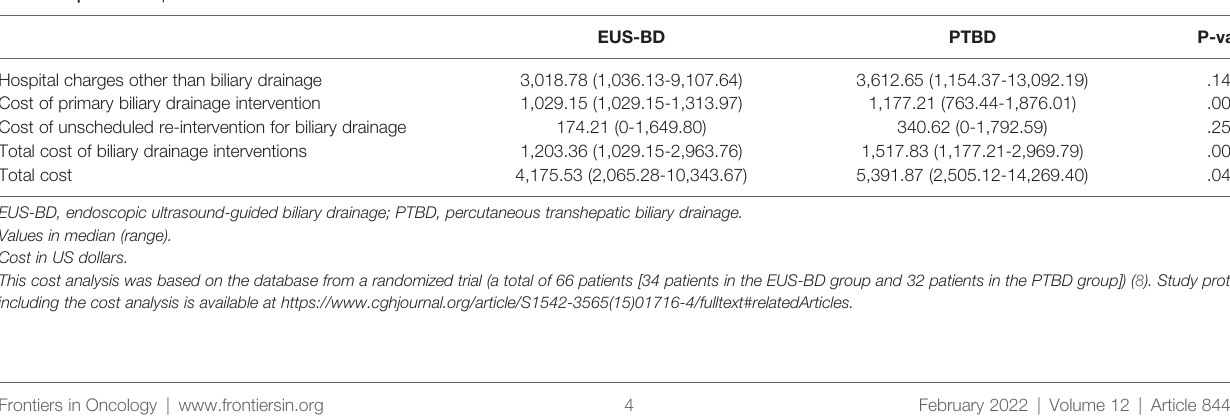
TABLE 2 | Cost comparison of EUS-BD and PTBD in